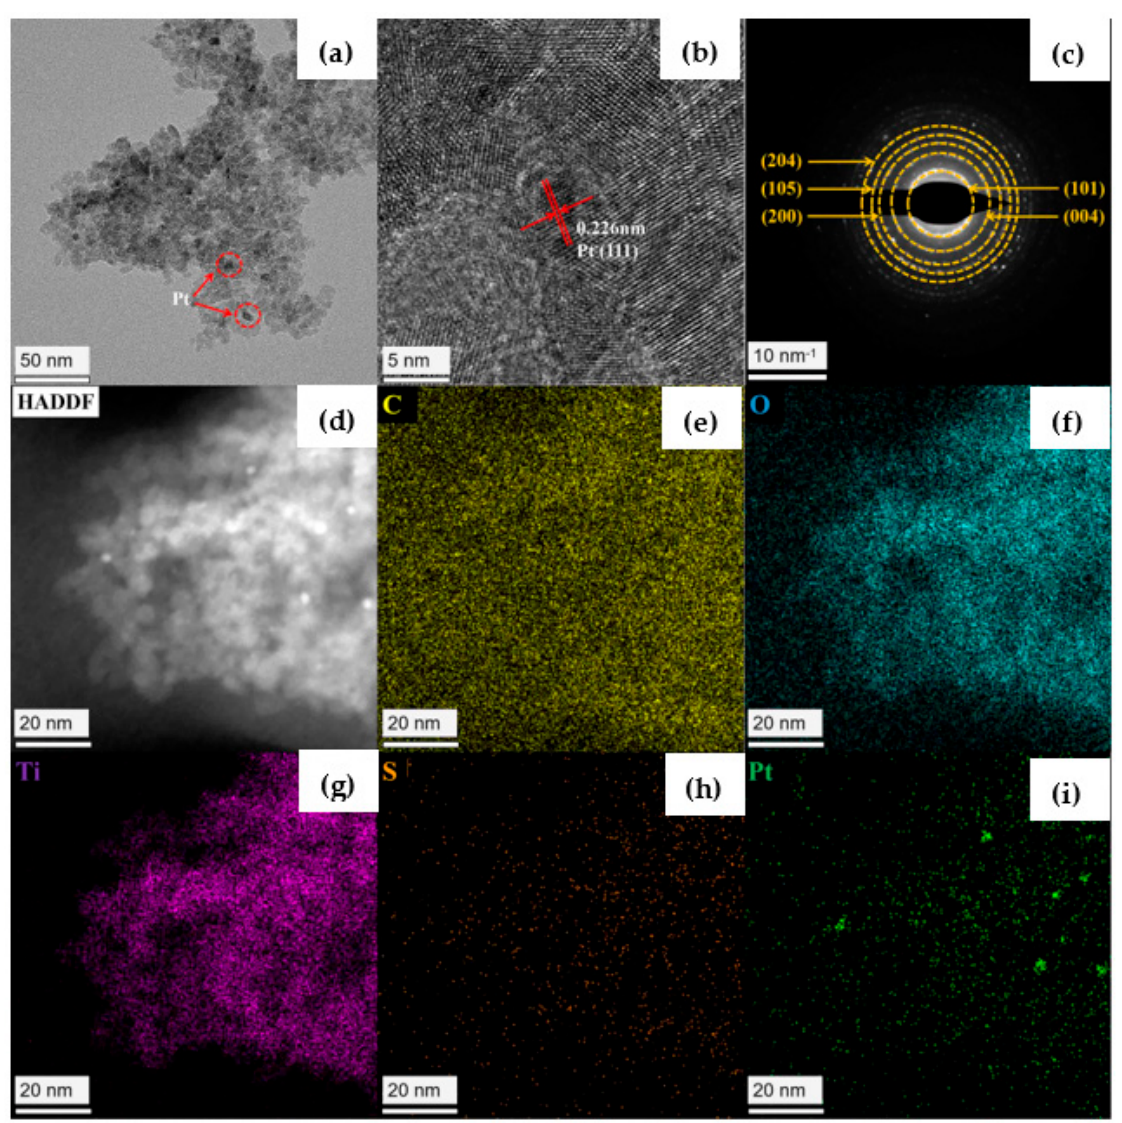
Figure 3. ( a ) TEM, ( b ) HRTEM, ( c ) SAED of H 4 TTFTB-TiO 2 and ( d – i ) the elemental mappings image of Pt@ H 4 TTFTB-TiO 2 -5.0.